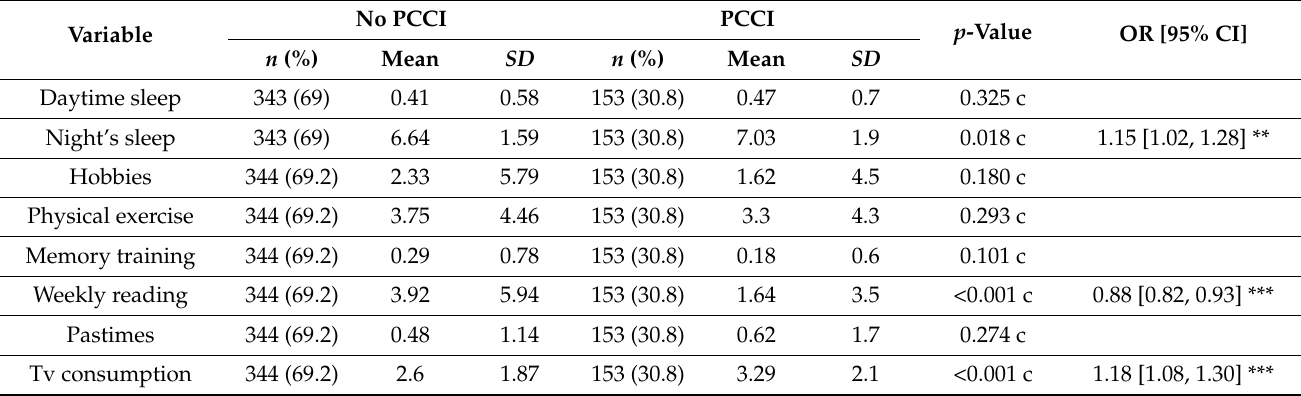
Table 6. Association between PCCI or No PCCI and the quantitative variables on living and intellectual